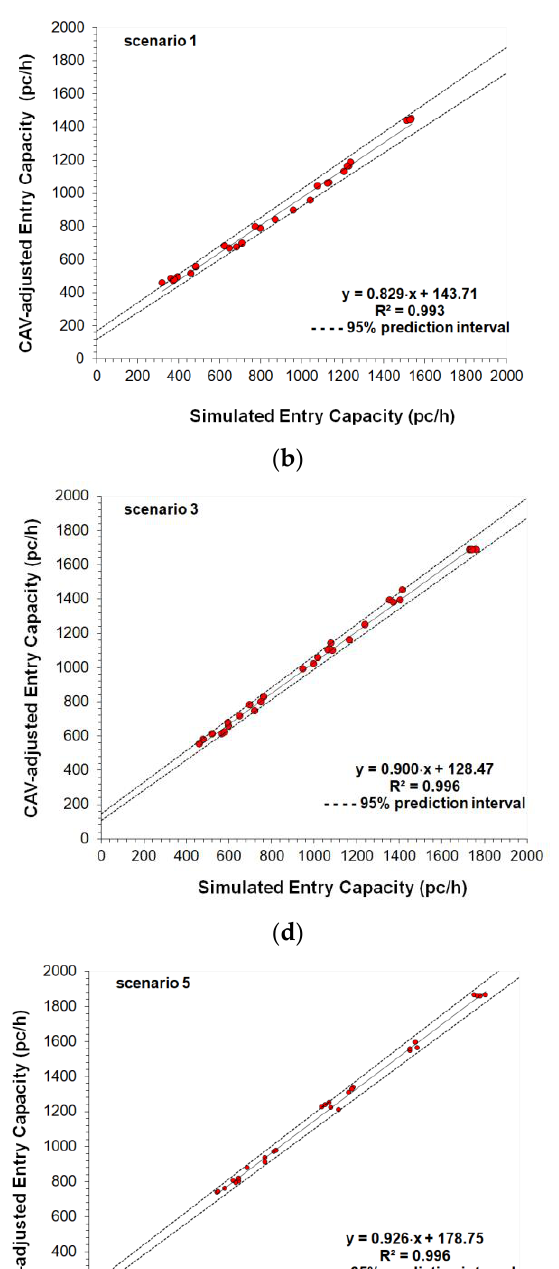
( f ) Figure 5. Comparisons between the CAV-adjusted and simulated entry capacity data for different market penetration rates of CAVs and HDVs for the entry mechanism 1 (i.e., one-lane entry con- flicted by one circulating lane) listed as: ( a ) baseline scenario: 0% CAVs and 100% HDVs; ( b ) scenario 1: 20% CAVs and 80% HDVs; ( c ) scenario 2: 40% CAVs and 60% HVs; ( d ) scenario 3: 60% CAVs and 40% HDVs; ( e ) scenario 4: 80% CAVs and 20% HDVs; ( f ) scenario 5: 100% CAVs and 0% HDVs. Notes: to explain the entry mechanisms 1 reference has been made to the eastbound entry in Figure